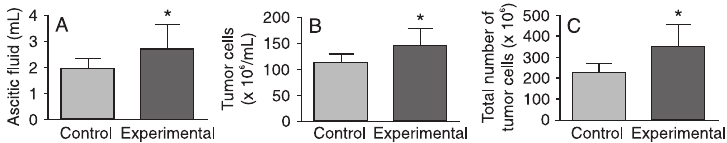
Figure 1. Effects of cyhalothrin (3 mg·kg -1 ·day -1 ) for 7 days (black columns) on Ehrlich tumor growth. Control mice (gray columns) were injected with control solu- tion (1.0 mL·kg -1 ·day -1 for 7 days). Mice received 5 x 10 6 Ehrlich tumor cells ip with the 1st treatment with cyhalothrin or control solution. A , Ascitic fluid volume; B , concentration of tumor cells/mL ascitic fluid; C , total number of tumor cells. Data are reported as means ± SD for N = 10 animals/group. * P < 0.05 compared to control (Mann-Whitney U-test).